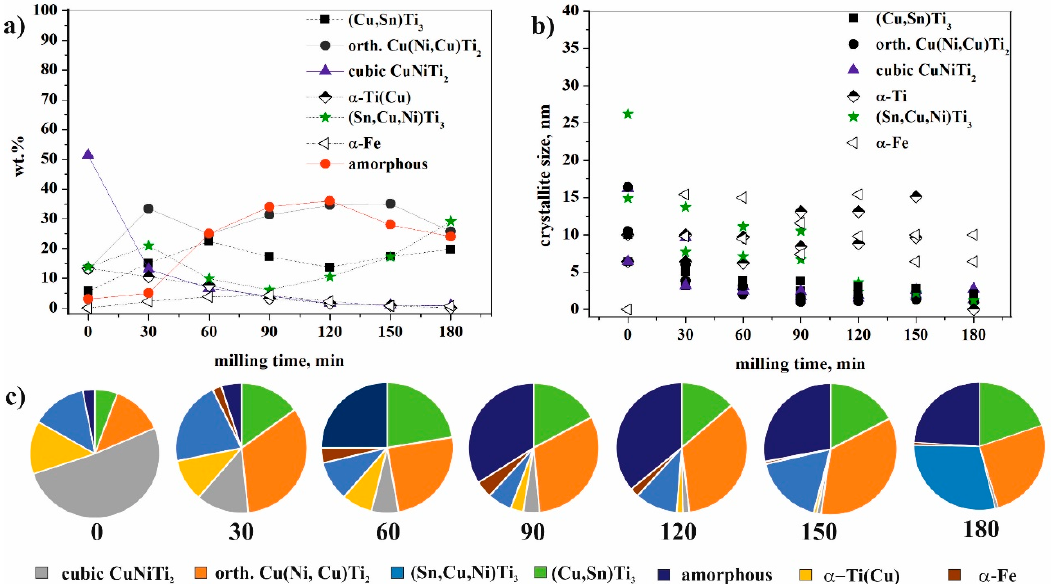
Figure 7. Fraction and featuring of ( a , c ) crystalline and amorphous phases and ( b ) crystallite size in the course of the milling process of Ti 50 Cu 25 Ni 20 Sn 5 alloy determined by XRD measurement. The amount of the hexagonal α -Ti(Cu) phase continuously decreased, and this phase disappeared after 180 min of milling.